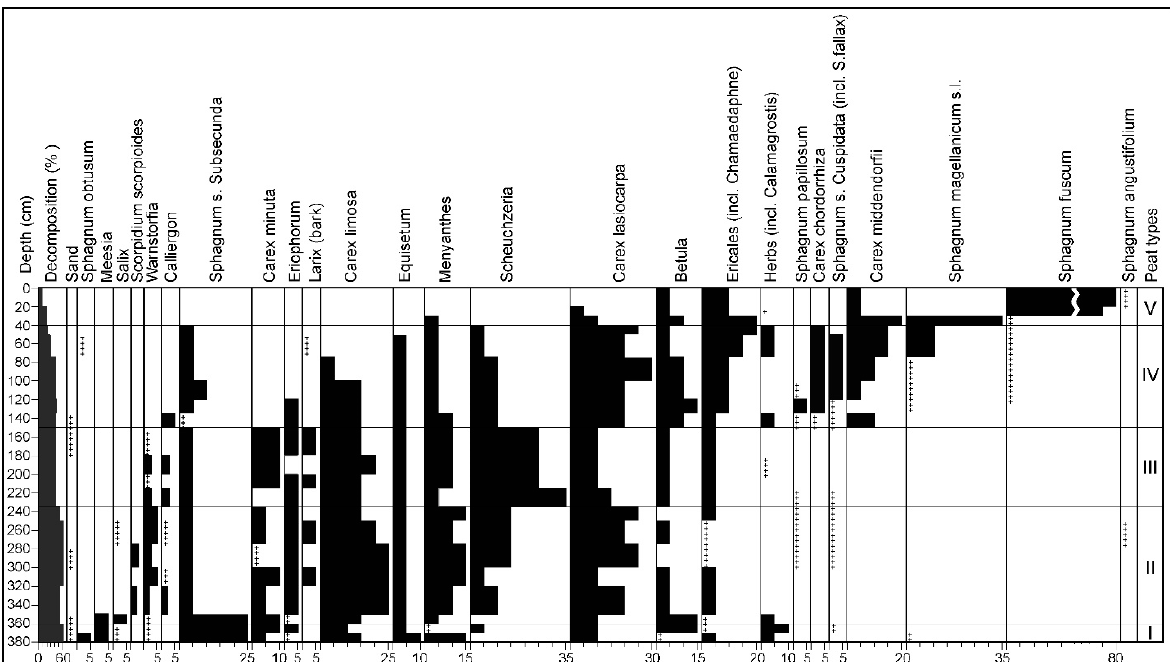
Figure 5. Botanical composition of peat under string. Peat types: I—eutrophic sedge-sphagnum, II—eutrophic sedge, III—eutrophic Scheuchzeria-sedge, IV—eutrophic dwarf shrub-sedge and V— mesotrophic sedge-dwarf shrub-sphagnum.